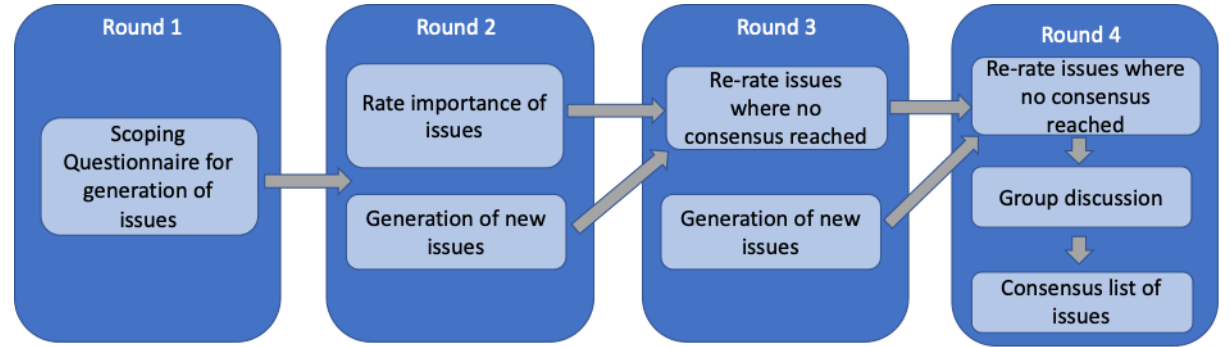
Figure 1. Structure of the Delphi